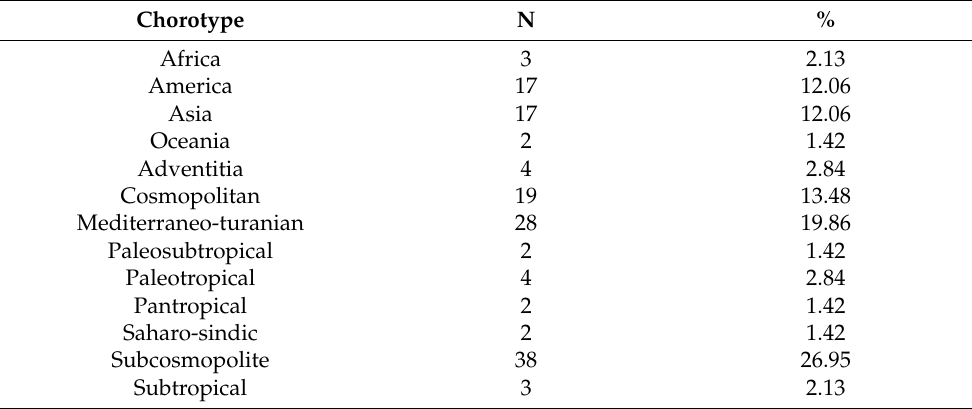
Table 6. Chorology spectrum of wide distribution species, divided by chorotypes Chorotype